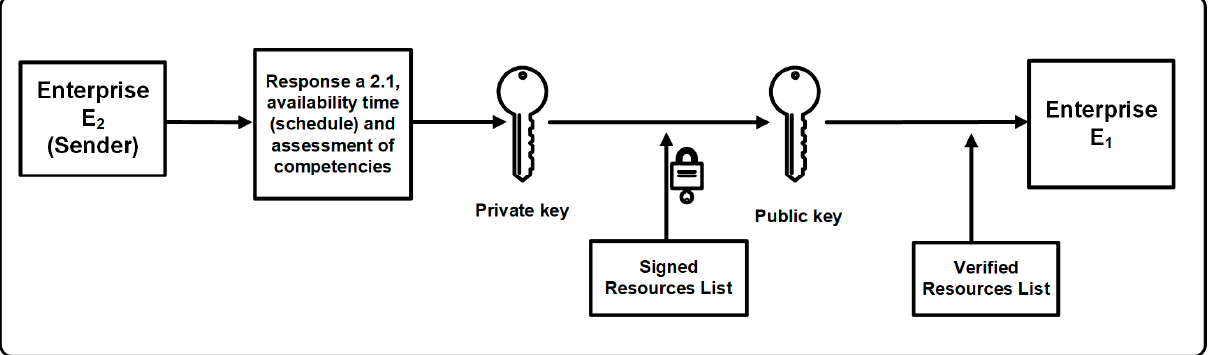
Figure 8. The procedure of signing and verifying signatures for the question about employee